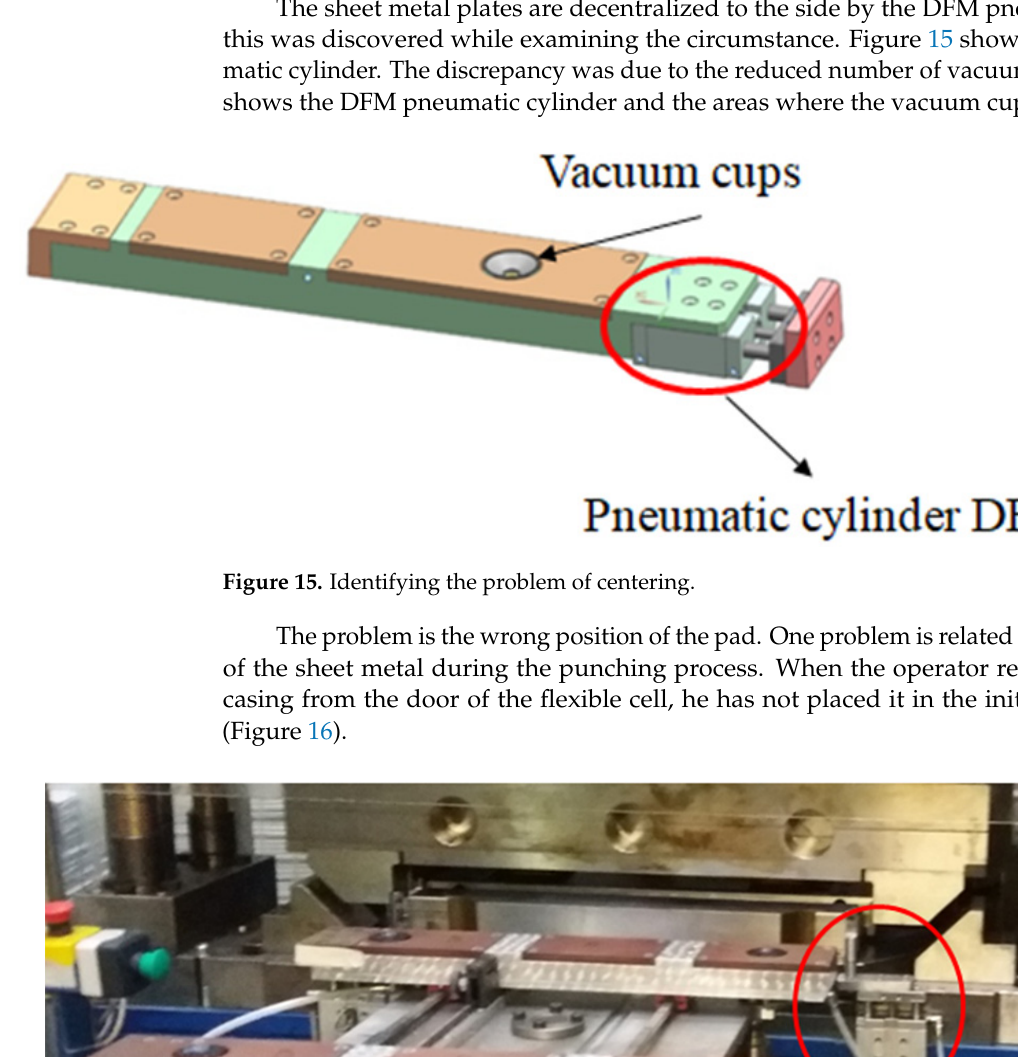
Figure 16. The stop position of the engine.